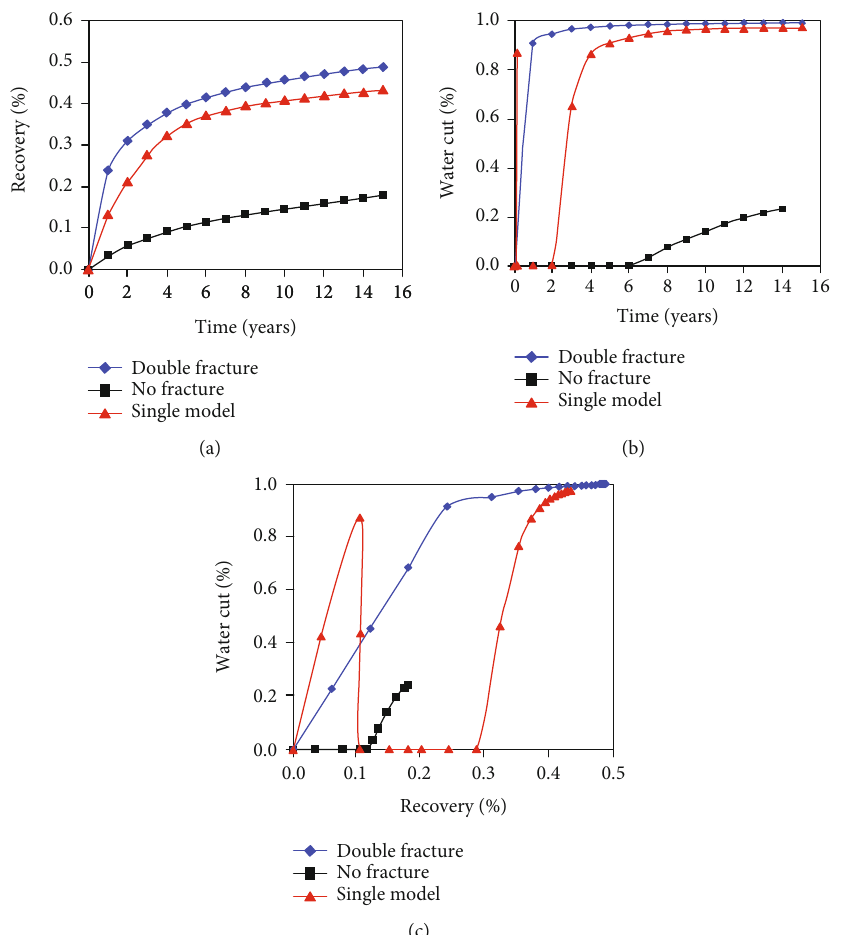
Figure 5: The production curves for di ff erent numbers of dynamic fracture. (a) Recovery versus time, (b) water cut versus time, and (c) water cut versus